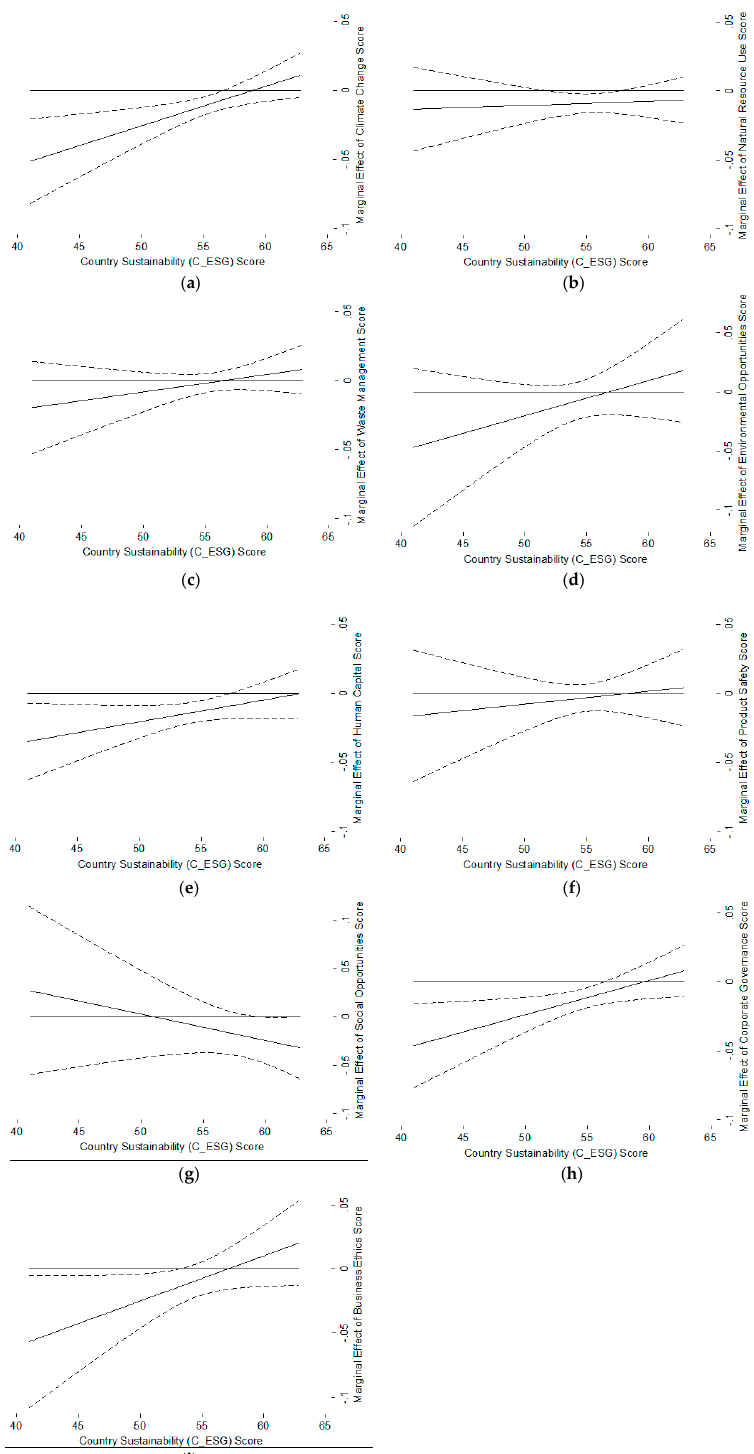
Figure 1. This figure shows the marginal effects on credit risk across different values of country sustainability (C_ESG) for the following corporate social performance (CSP) dimensions: ( a ) climate change; ( b ) natural resource use; ( c ) waste management; ( d ) environmental opportunities; ( e ) human capital; ( f ) product safety; ( g ) social opportunities; ( h ) corporate governance; and ( i ) business